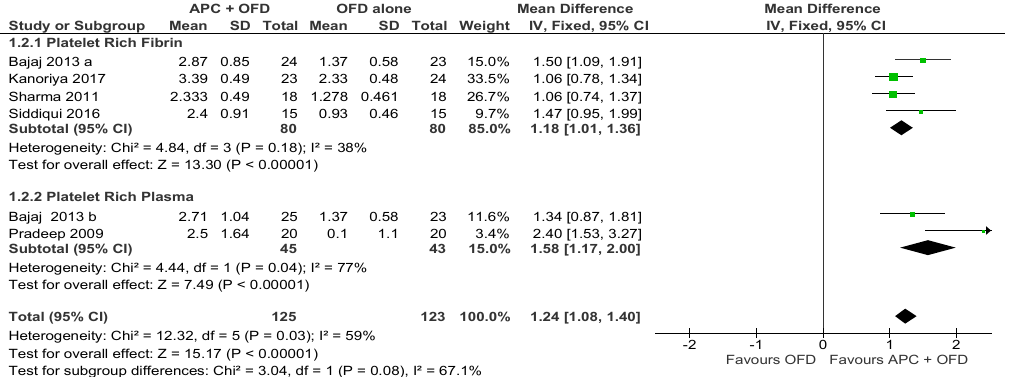
Figure 5. Forest plot showing the effect on vertical clinical attachment level for comparison of APC + OFD versus OFD alone at end of all-follow-up (6–12 m).